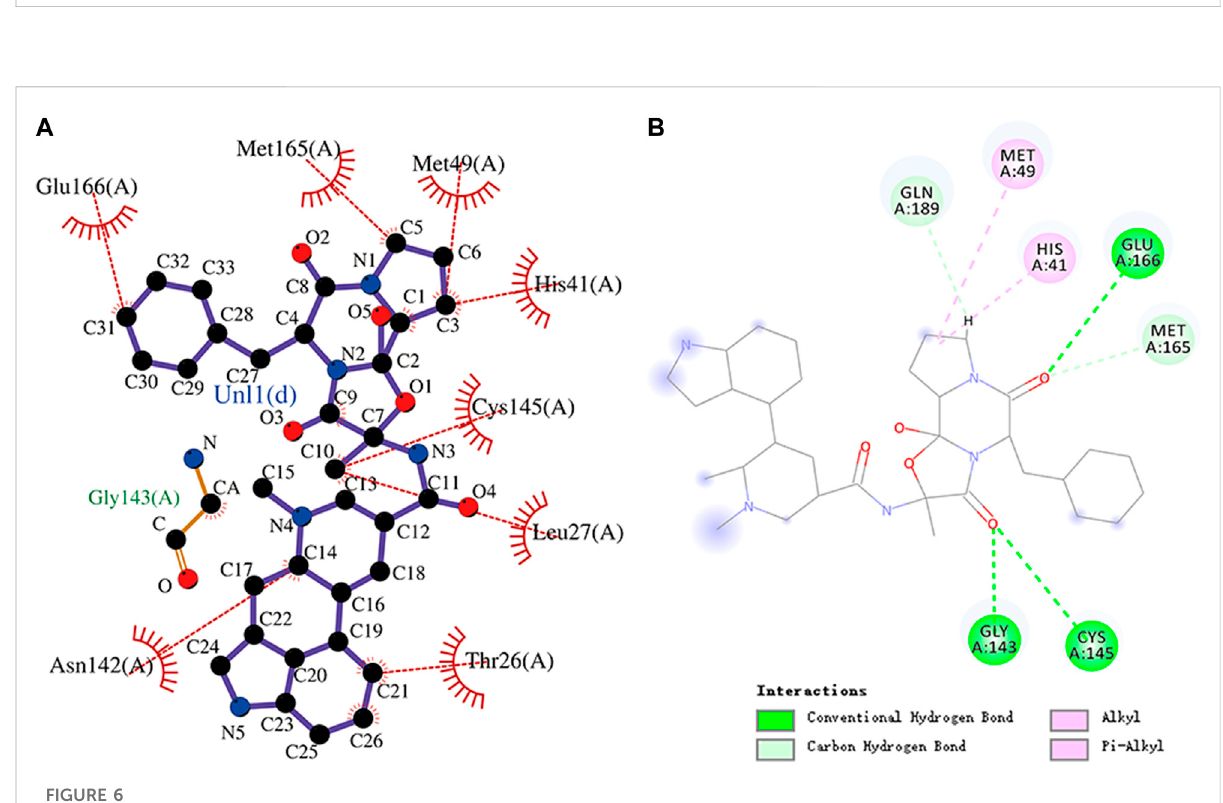
FIGURE 6 (A) Hydrophobic interaction between M pro and ergotamine and (B) two-dimensional plot of ergotamine interaction with the amino acid residues.